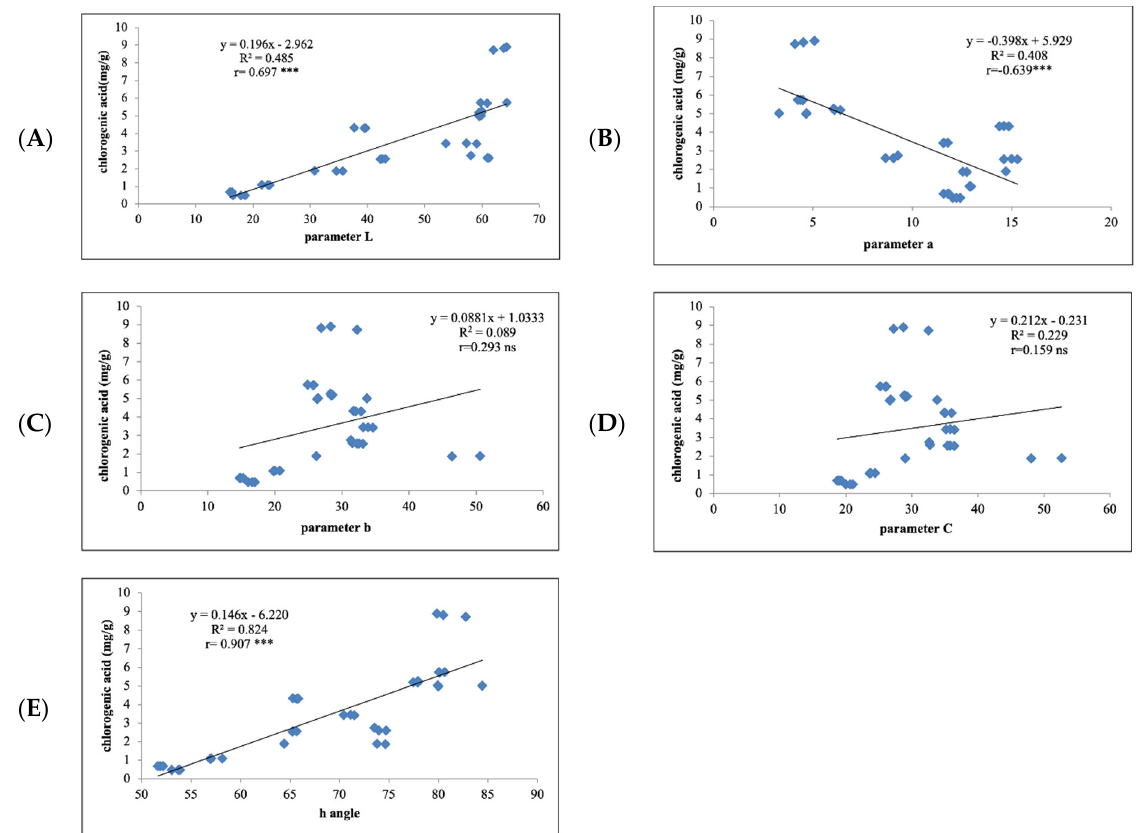
Figure 2. The correlation between ground roast coffee color ( A ) L*, ( B ) a*, ( C ) b*, and ( D ) C*, and ( E ) hue angle with chlorogenic acid content. (*: p < 0.05, **: p < 0.01, ***: p < 0.001, ns: no significant).